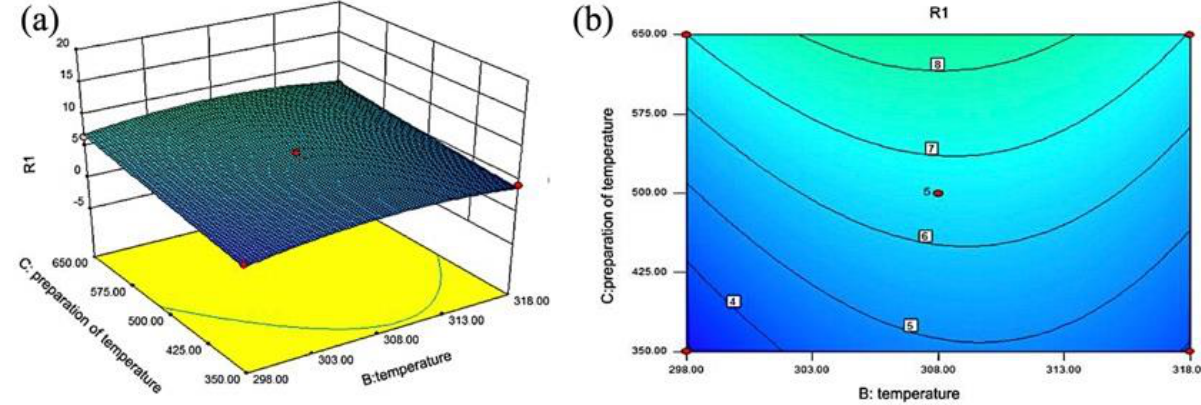
Figure 8. The ( a ) three-dimensional view and ( b ) top view for interaction between experimental temperature and preparation temperature T.